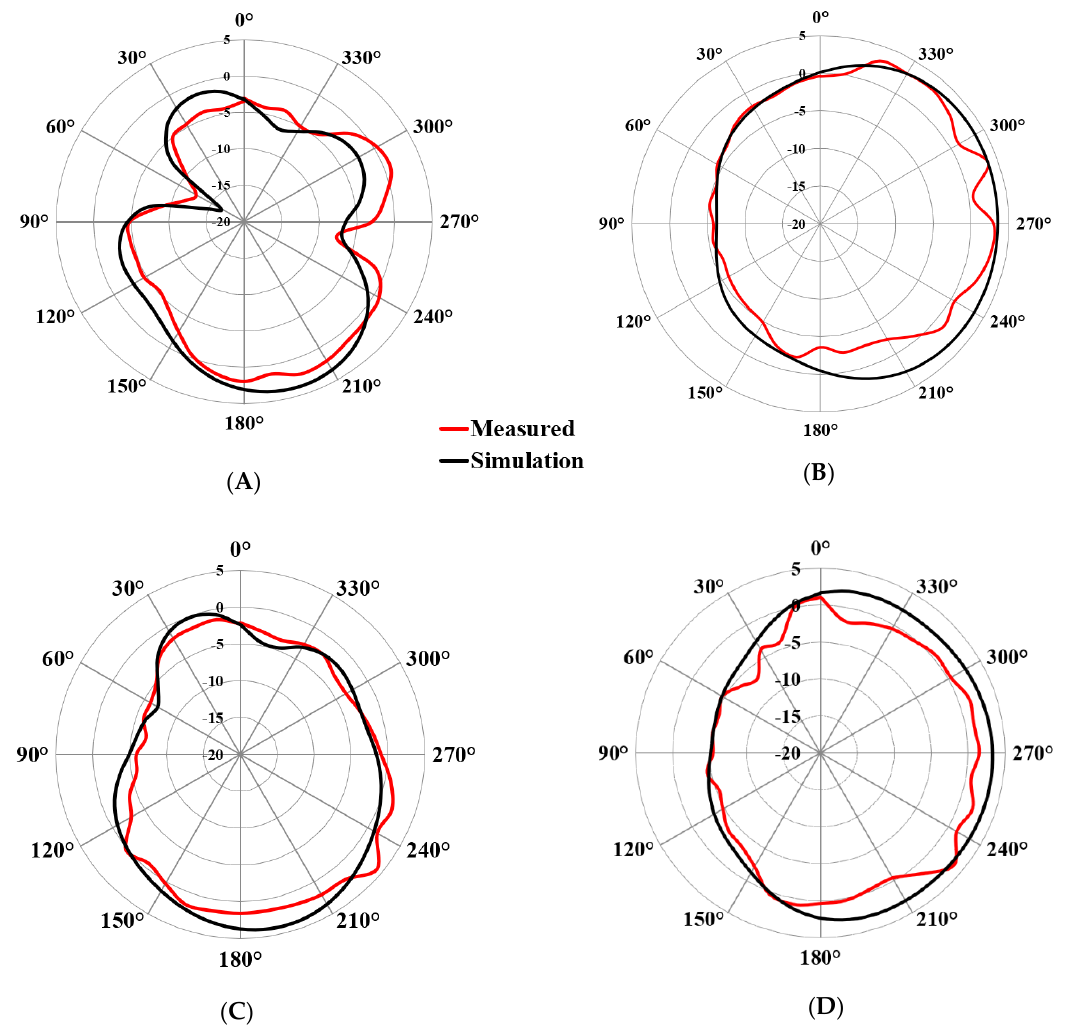
Figure 11. Simulation and measured radiation pattern for port 1: ( A ) 3.4 GHz at YZ plane, ( B ) 3.4 GHz at XZ plane, ( C ) 4.8 GHz at YZ plane, and ( D ) 4.8 GHz at XZ plane.